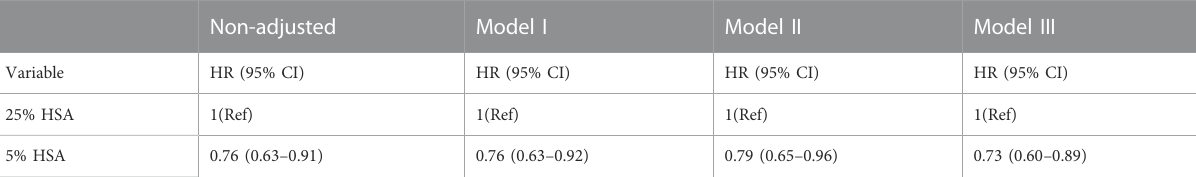
TABLE 4 Multivariate Cox regression for 5% HSA on 28-day mortality of patients in matched cohort.